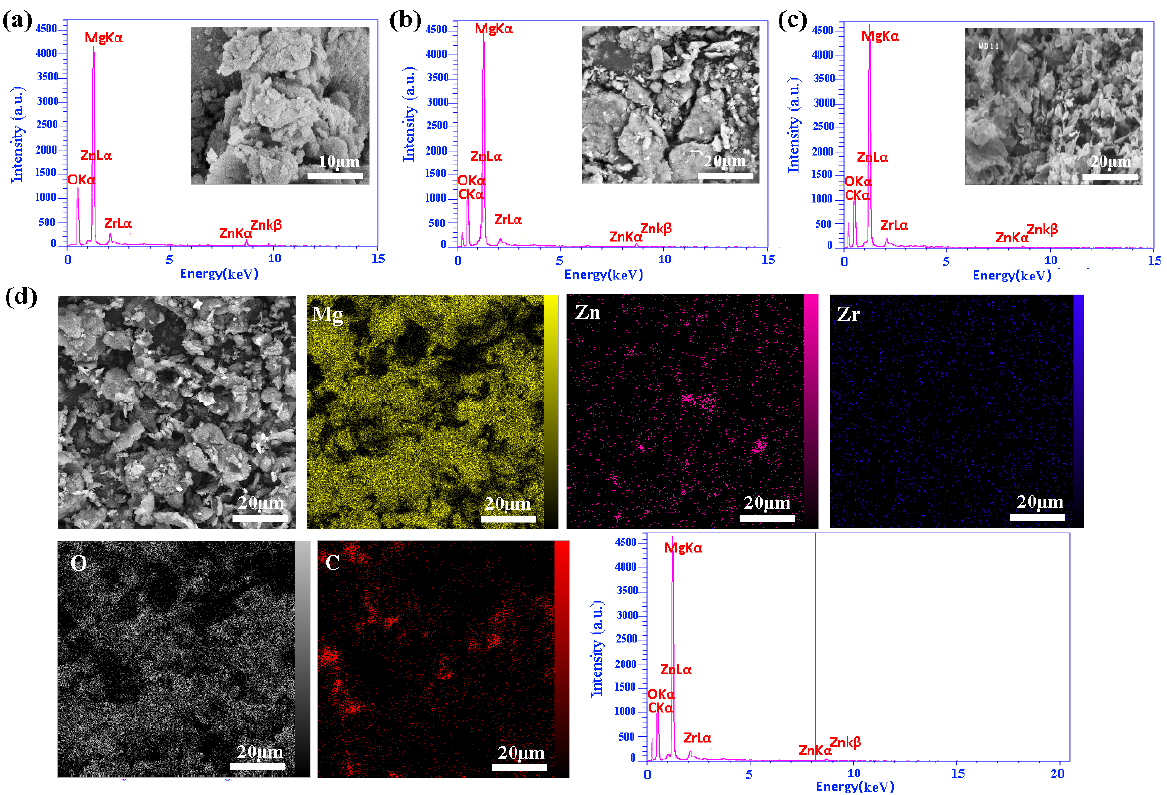
Figure 4. SEM images and EDX spectra of ( a ) MZ ( b ) MC1 ( c ) MC3 and ( d ) map images of MC2 powder composite.